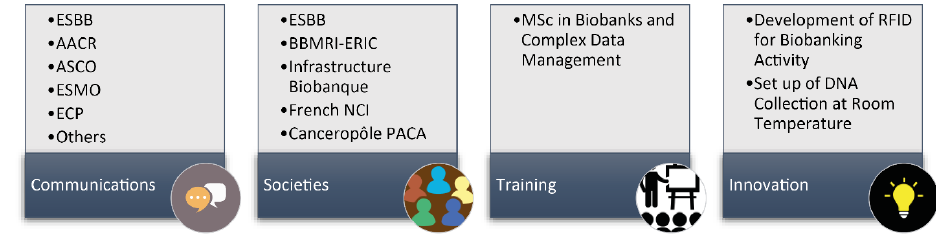
Figure 4. Diffusion of information. Some examples of different action concerning the dissemination